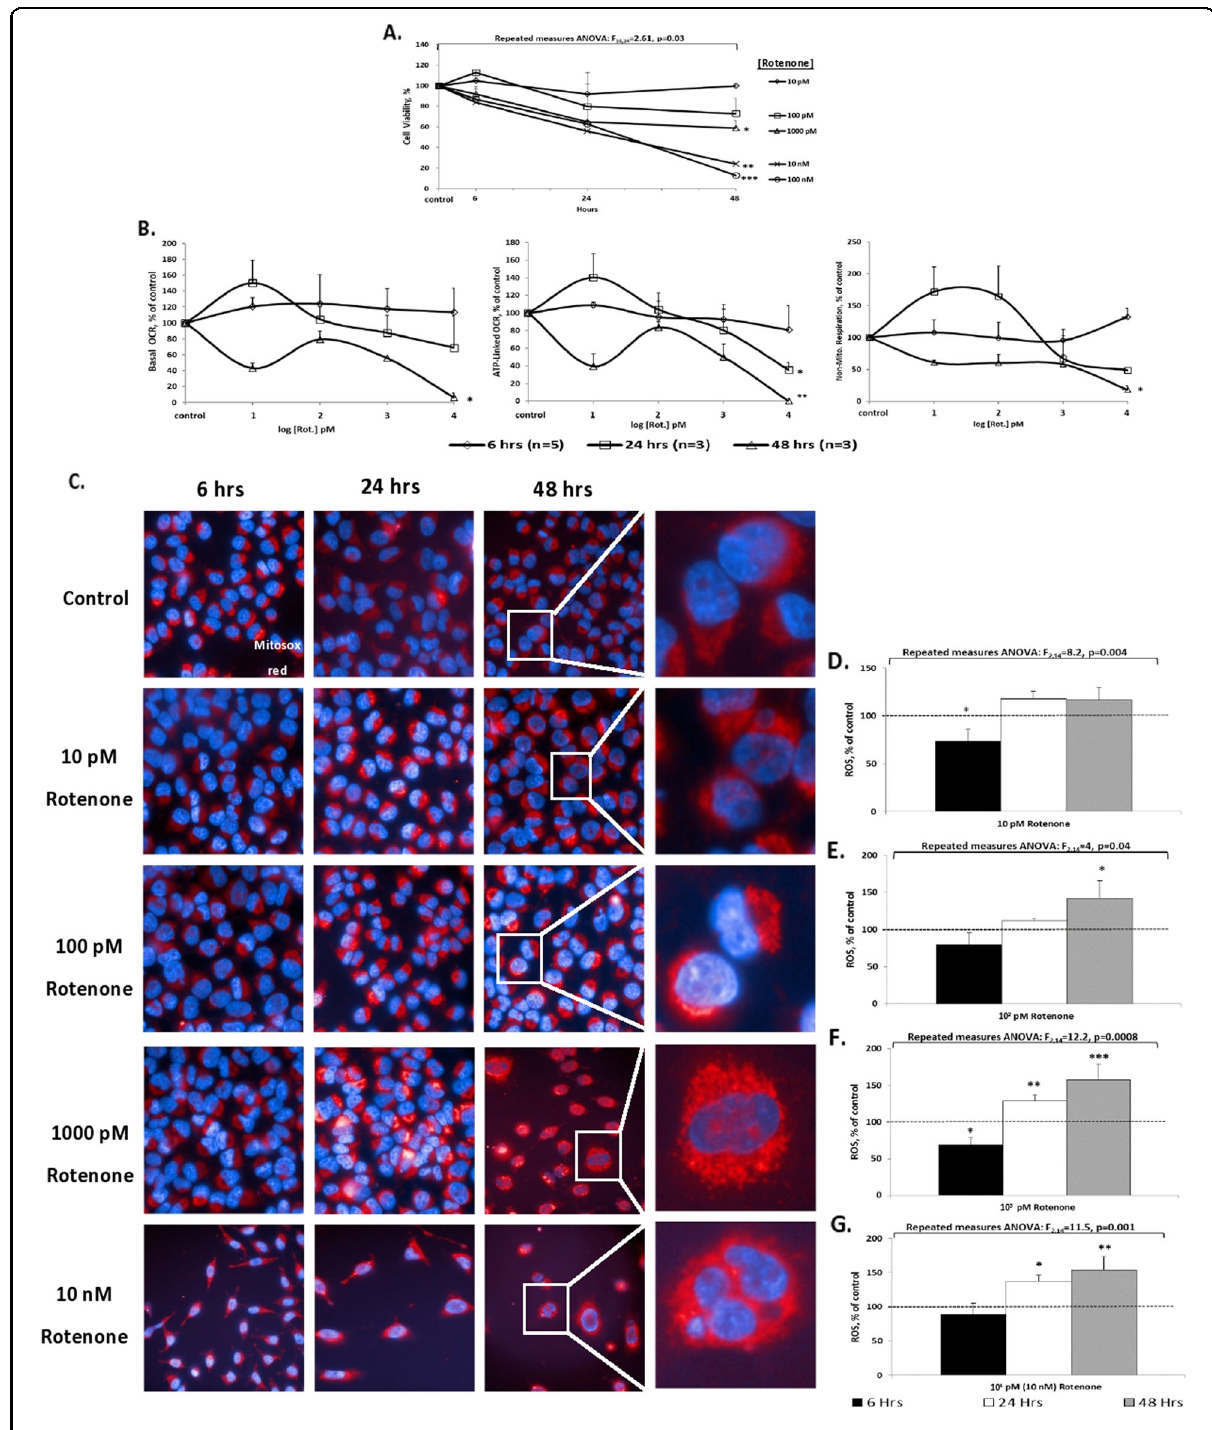
Fig. 1 (See legend on next